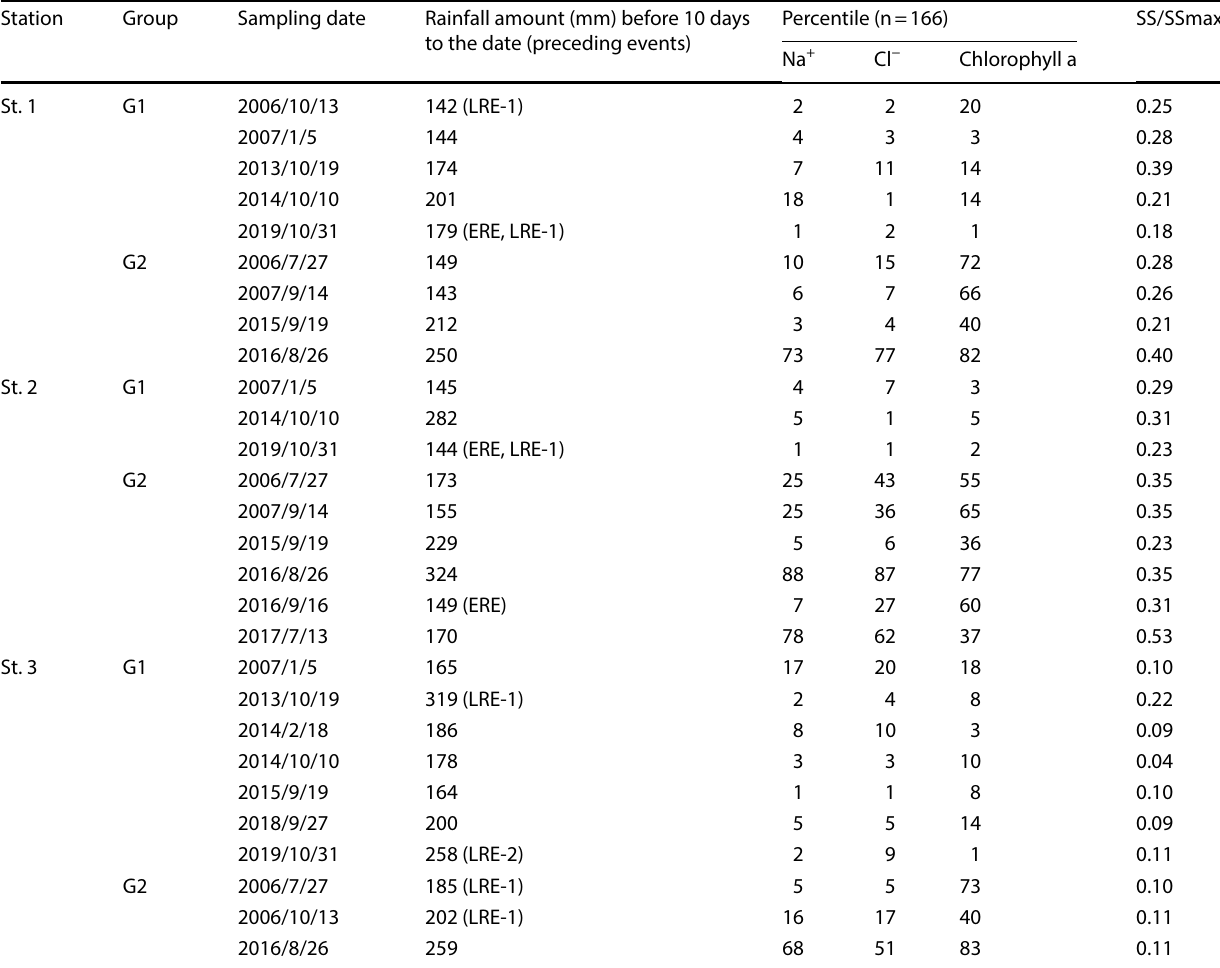
Table 2 Characteristics of the Na + , Cl − , and Chla concentrations on the sampling days after extreme rainfall events (≥ 140 mm during the 10 preceding